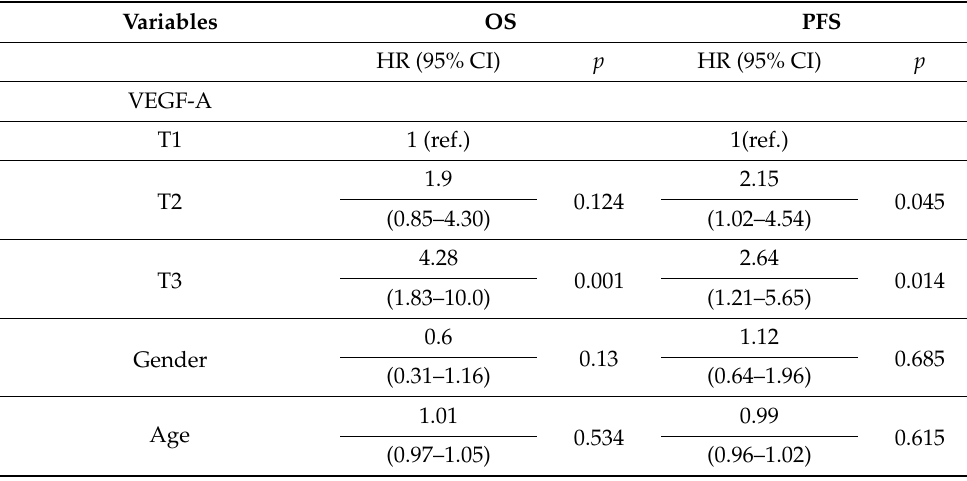
Figure 1. Prognostic value of basal VEGF-A and ACE plasma levels in the first-line treatment of mCRC patients with chemotherapy plus bevacizumab: ( A ) effect of basal VEGF levels on PFS outcome; ( B ) effect of basal VEGFA levels on OS outcome; ( C ) effect of basal ACE levels on PFS outcome; and ( D ) effect of basal ACE plasma levels on OS outcome. Table 2. Multivariate analysis of OS and PFS including tertiles of